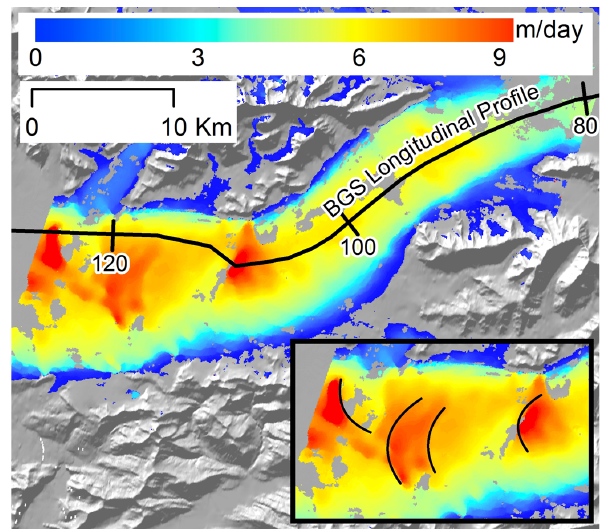
Fig. 3. High-resolution velocity field during second phase of the surge over 11 day interval (5–16 July 2011) from TerraSAR-X. Lo- cation of propagation fronts marked in inset